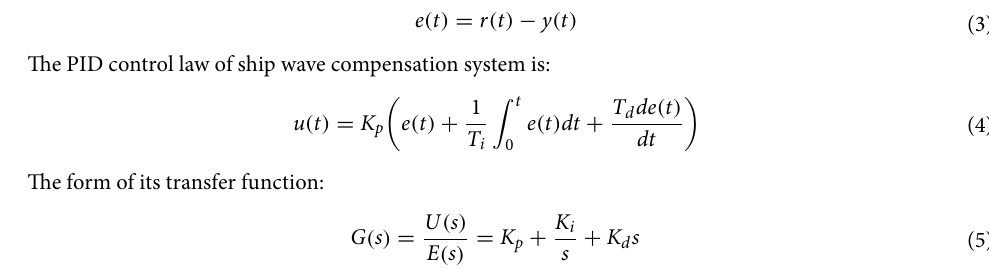
Figure 2 is a schematic diagram of the ship’s wave compensation platform structure, which is divided into an upper platform and a lower platform, connected by six driving cylinders. The lower platform is placed on the ground, and the upper computer controls the movement of the upper platform by controlling the elongation of each drive cylinder. Figure 3 is a block diagram of the PID control principle of the ship wave compensation system. The control system is composed of a PID controller and a controlled object. The controlled object is each drive cylinder of the designed wave compensation mechanism. The PID control of the ship wave compensation system is a linear controller, which constitutes a control deviation according to the given value r(t) and the actual output value y(t):